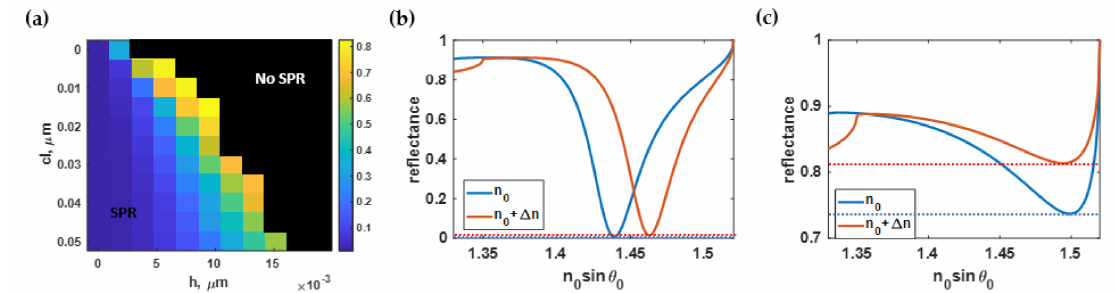
Figure 14. ( a ) The dip intensity calculated using Monte Carlo simulation; ( b ) SPR dips at h of 1 nm and cl of 50 nm with an average dip intensity of 0.01; and ( c ) SPR reflectance spectrum at h of 5 nm and cl of 10 nm with an average dip intensity of